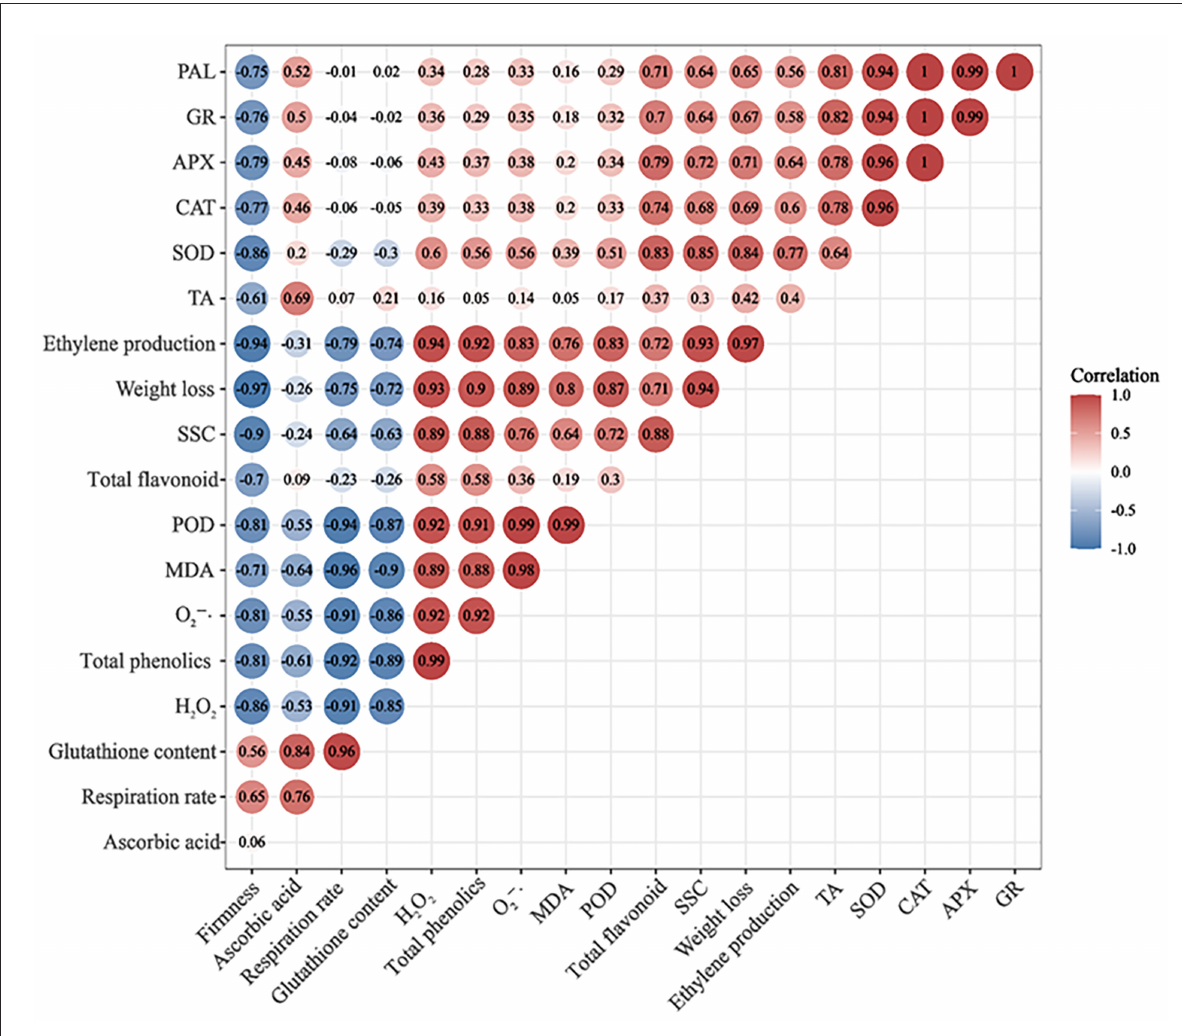
FIGURE7 Correlation analysis of fruit quality indexes and reactive oxygen metabolism in 1-MCP + SA treated winter jujube fruit. Dark color represents a strong correlation, light color represents a weak correlation, red color represents a positive correlation, and blue color represents a negative